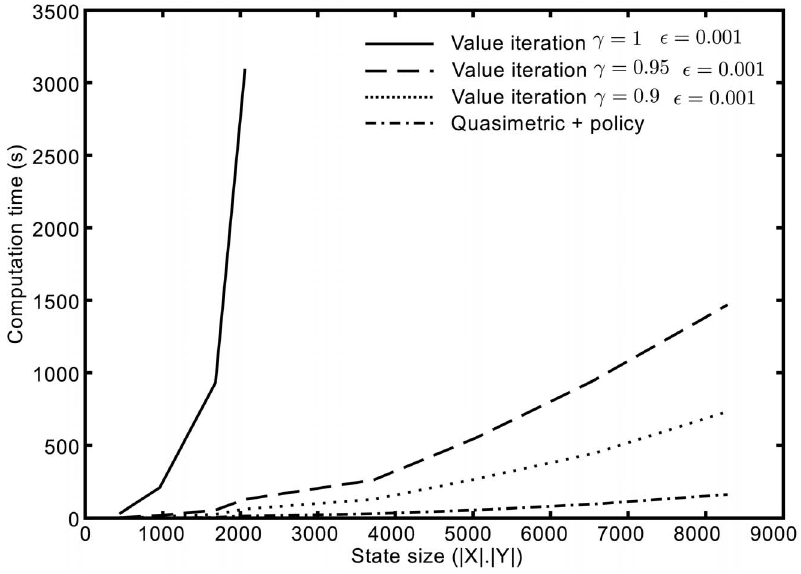
Figure 5. Comparison of computation time for the under-actuated pendulum example.